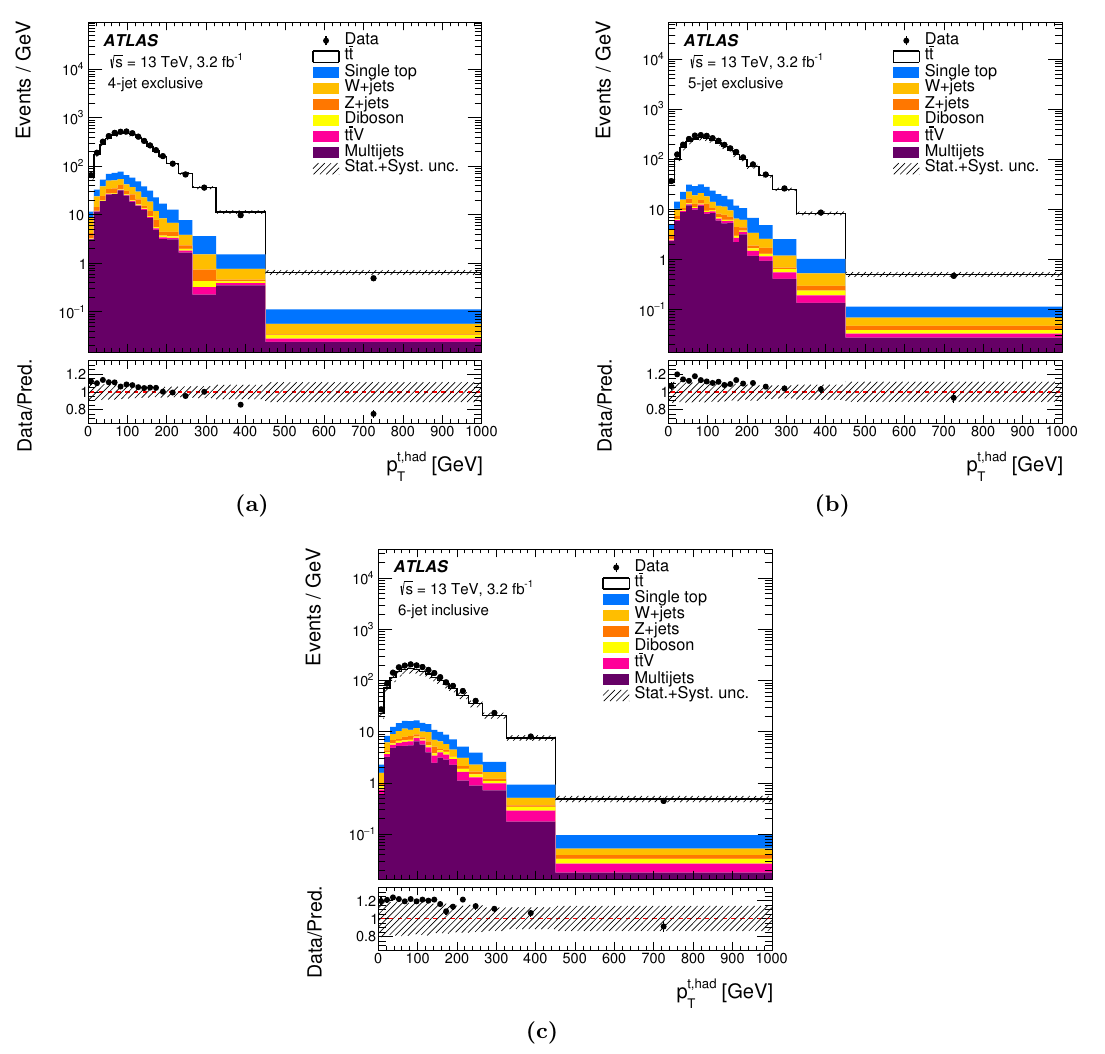
Figure 5 . Distributions of p t; had at reconstruction level: (a) 4-jet exclusive, (b) 5-jet exclusive T and (c) 6-jet inclusive con(cid:12)gurations. Data are compared to the sum of signal and background pre- dictions using the nominal sample as the t (cid:22) t signal model. The hatched area indicates the combined statistical and systematic uncertainties in the total prediction, excluding systematic uncertainties related to the modelling of the t (cid:22) t production. Events beyond the range of the horizontal axis are included in the last